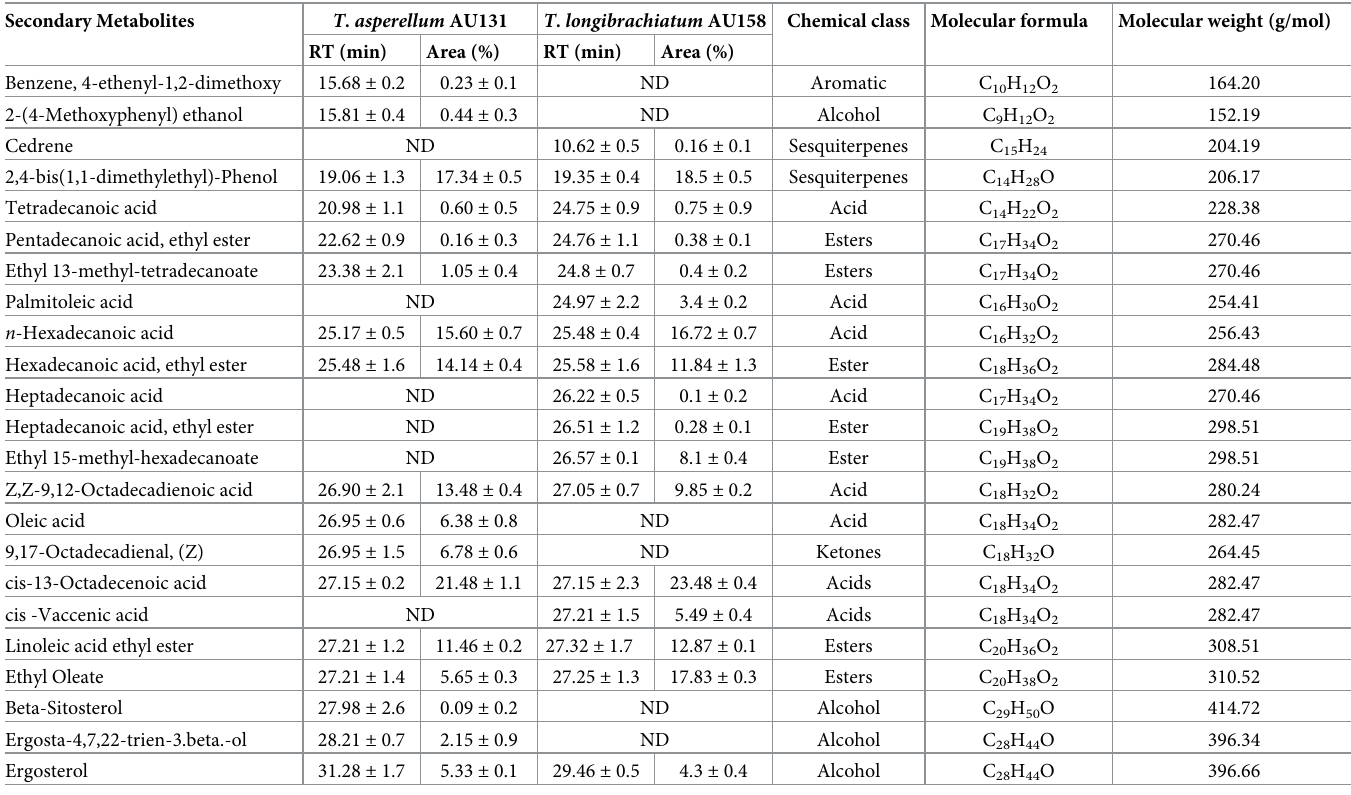
Table 1. Volatile organic compounds of T . asperellum AU131 and T . longibrachiatum AU158 identified by